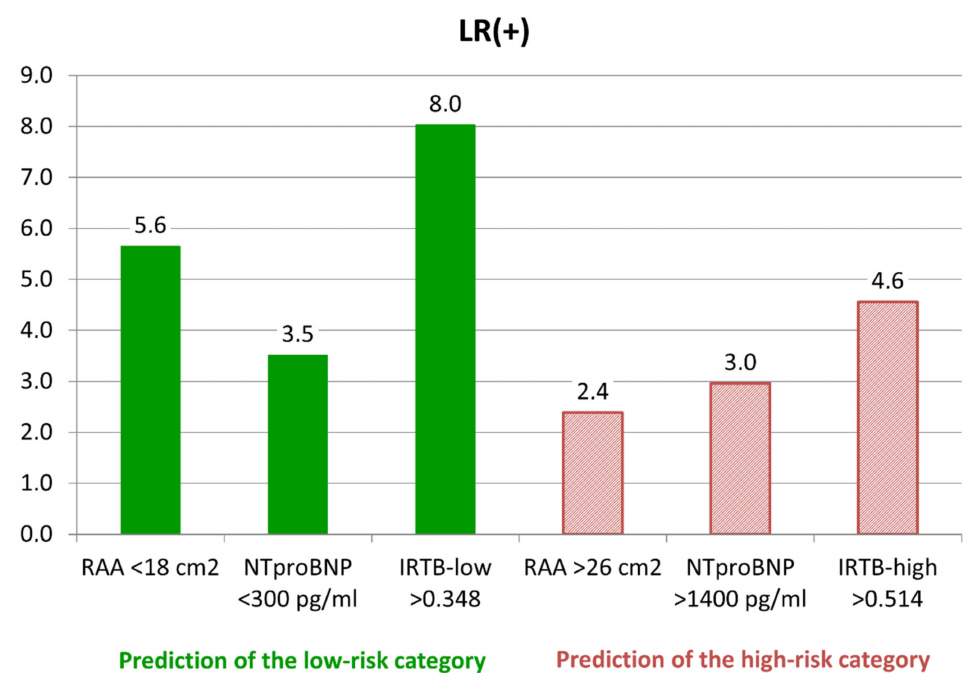
Figure 1. Likelihood ratio of positive result (LR + )—comparison of di ff erent tests of the low-risk and high-risk categories identifications. Abbreviations: RAA—right atrial area, NTproBNP - N-terminated type B natriuretic pro-peptide, IRTB—multivariable models.